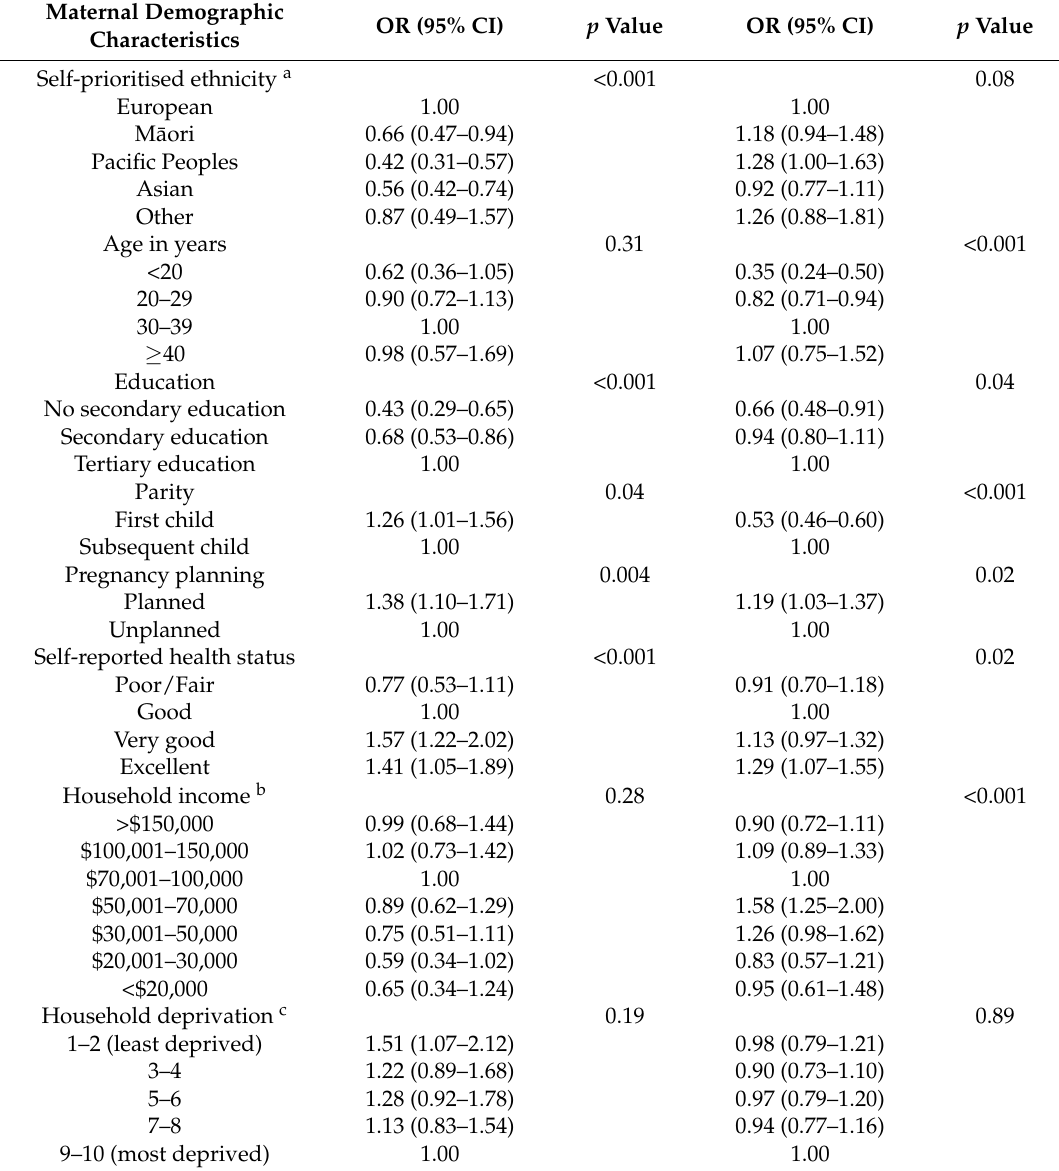
Table 3. Independent associations of the demographics of pregnant women with their intended infant feeding method and intended infant breastfeeding